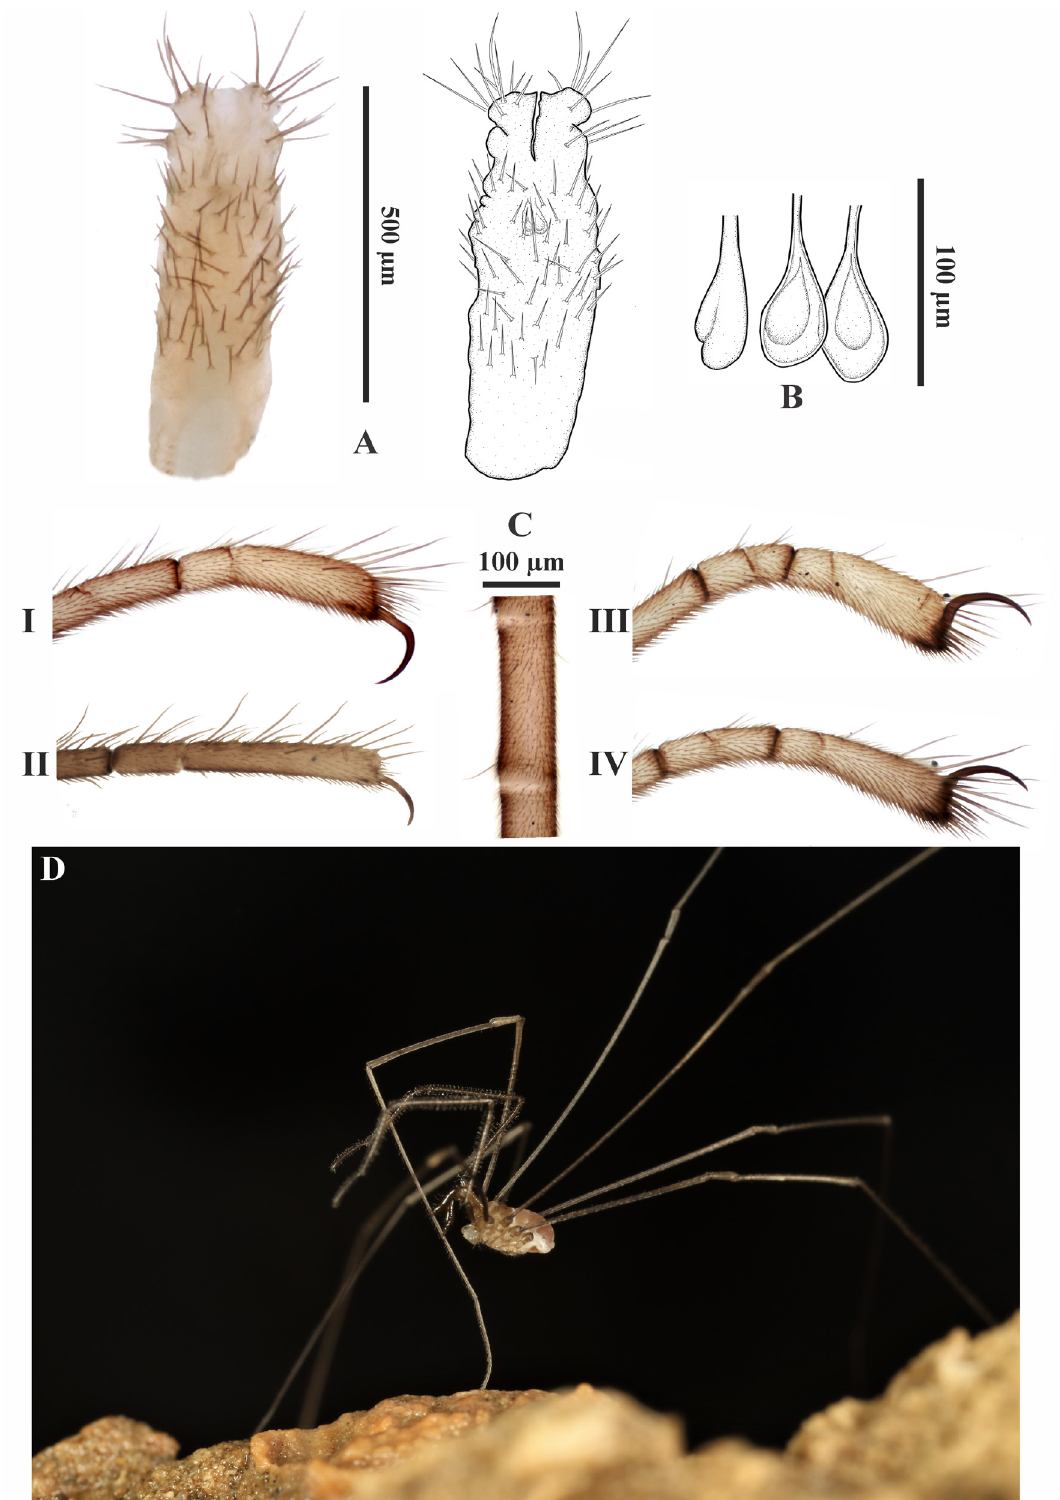
Fig. 5. Nemaspela borkoae sp. nov., ♀, allotype (PMSL-Opiliones-PK&TN 7/2019). A . Ovipositor, ventral view. B . Receptacula seminis, lateral (left) and ventral (right) views. C . Pseudoarticles in femur II, and distal tarsomerae I−IV with claws, lateral views. D . Female (PMSL-Opiliones-PK&TN 8/2019) in the natural habitat in Vodna jama u Dragalju Cave. Photograph by T.